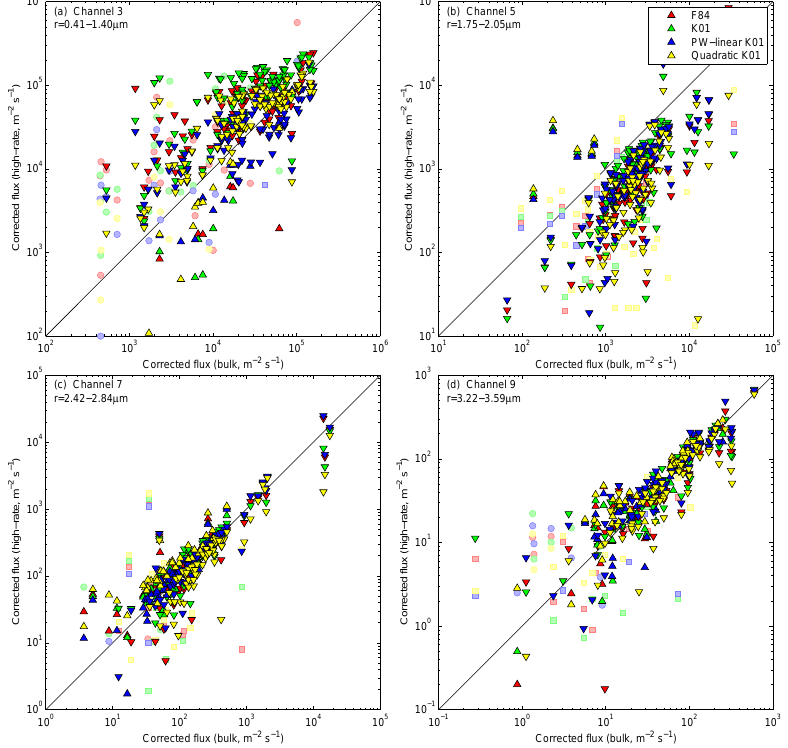
Fig. 13. Comparisons of the high-rate and bulk corrected fluxes for CLASP channels 3, 5, 7 and 9. Upward and downward pointing triangles show where both the high-rate and bulk fluxes are positive or negative, respectively. The lighter points show fluxes of different sign, for positive (circle) and negative (square) high-rate